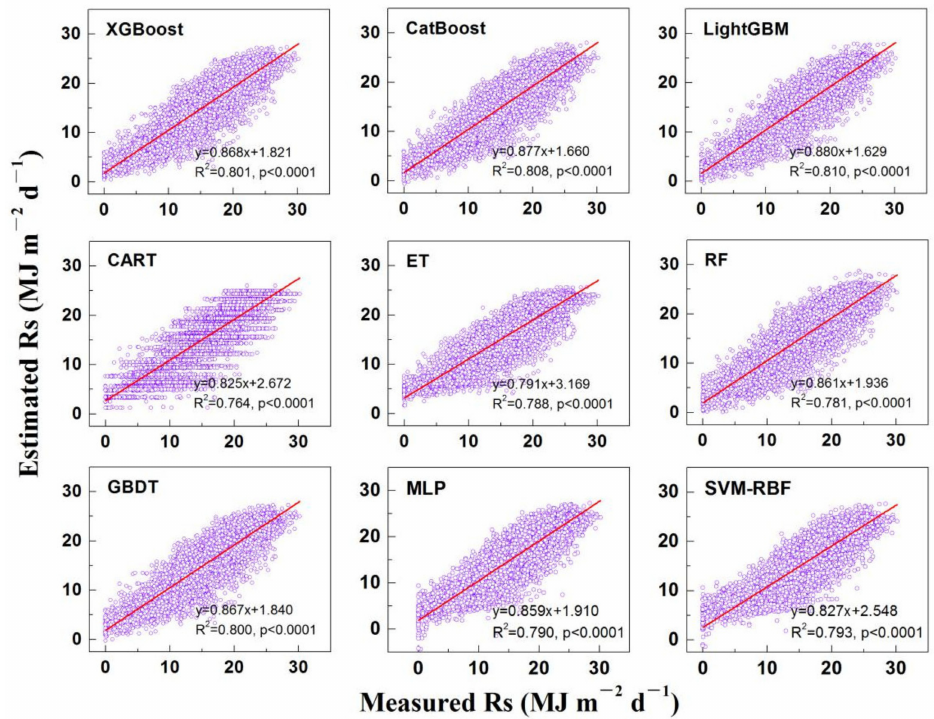
Figure 4. Same as in Figure 3 but at Sanya